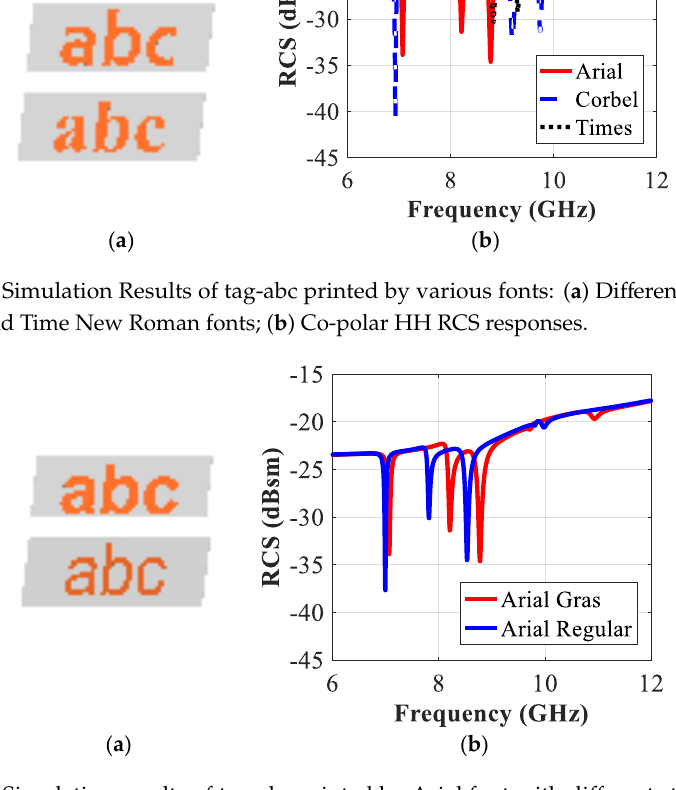
written by Arial gars and regular style; ( b ) Co-polar HH RCS responses.